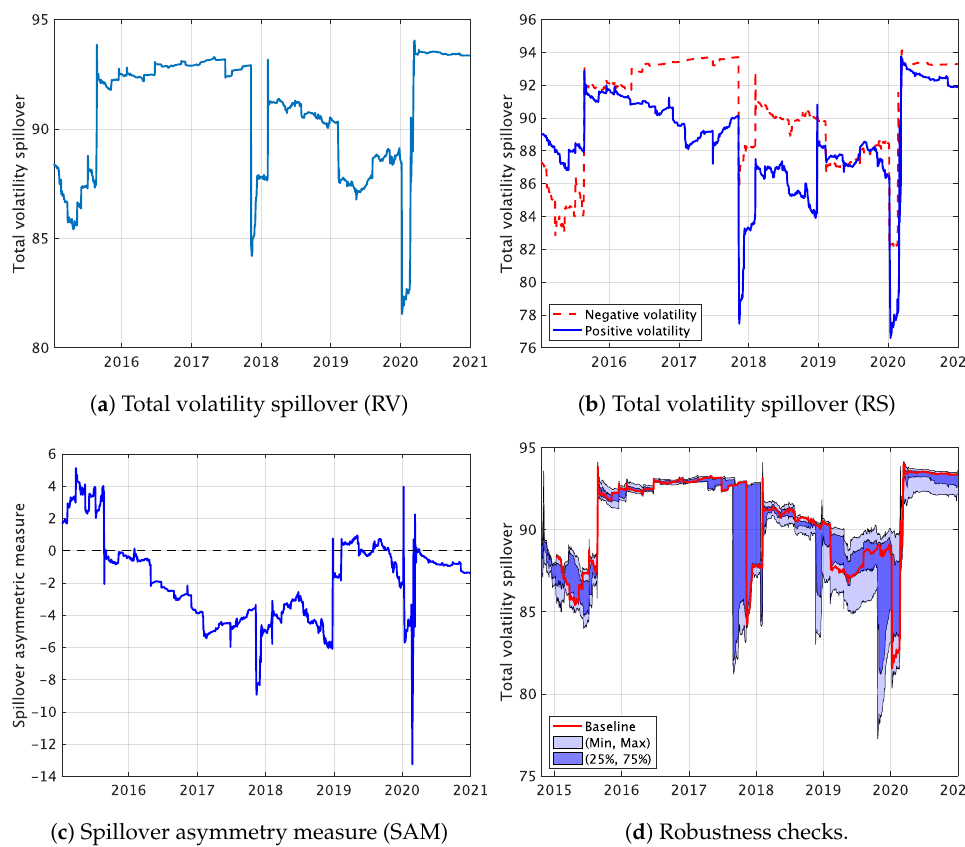
Figure 3. Total volatility spillover, spillover asymmetry measure, and robust check for rolling sample. Robustness